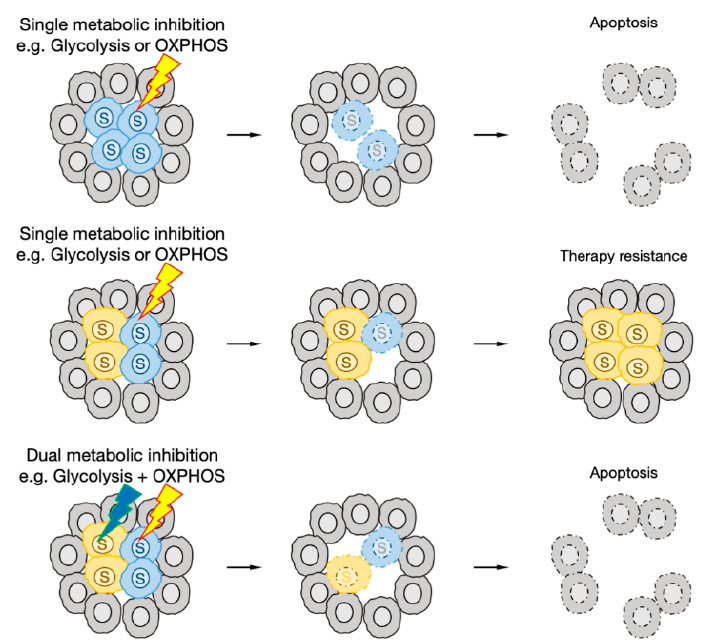
Figure 4. Therapeutic strategies targeting the metabolism of CSCs. If CSCs depend on a particular metabolism, a single metabolic inhibitor can effectively eliminate the tumor. When multiple CSCs with distinct metabolic phenotypes are present in the same tumor, it is necessary to simultaneously inhibit multiple metabolic pathways to eliminate the tumor.